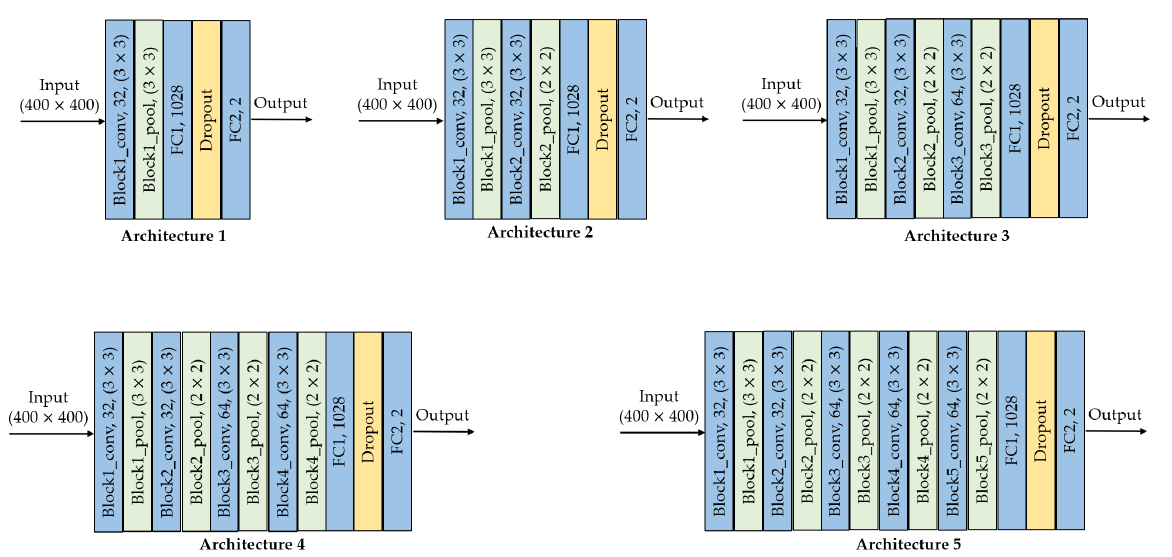
Figure 1. Architectures by custom design: conv is the convolutional layer, pool is pooling layer, FC is the fully-connected layer. Table 1. Hyperparameters of the proposed architectures by custom design: k is the kernel size, s is stride, p is padding. Layer No. of Filters or